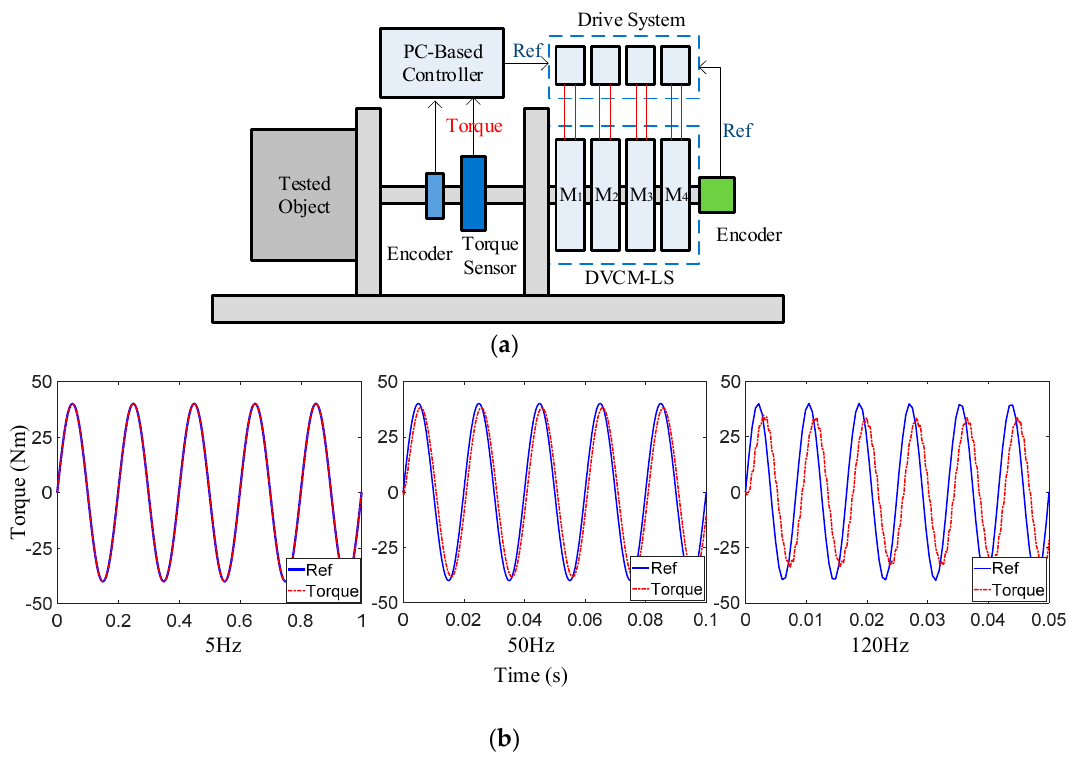
Figure 16. Dynamic experiments with the prototype: ( a ) Operation principle of the prototype; ( b ) Dynamic responses.